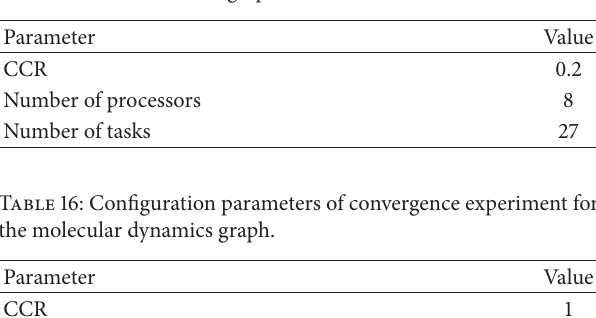
Table 15: Configuration parameters of convergence experiment for the Gaussian elimination graph.